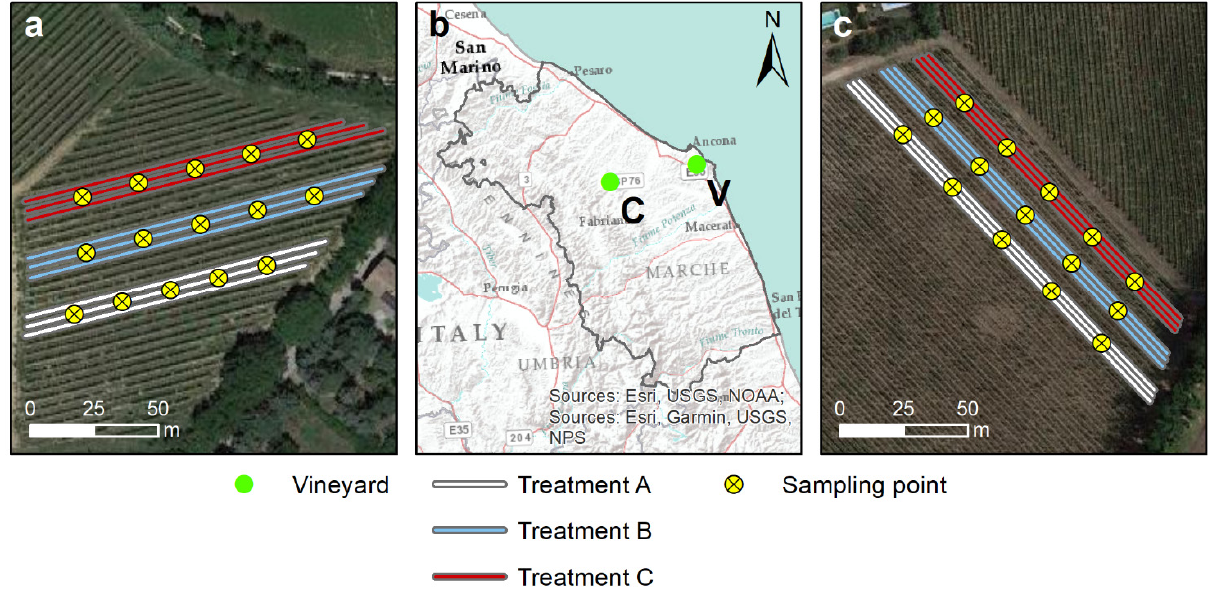
taken at the two depths of 0–20 cm (Z) and 20–40 cm (Q).